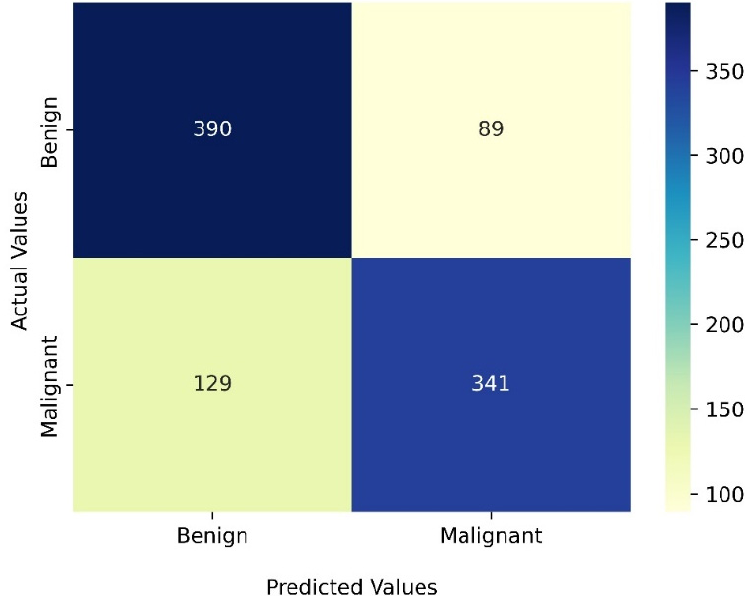
Figure 4. Confusion matrix of the two-view tiny DeiT’s classification results. Table 2. Result comparisons of the proposed model and other models. Params means the number of parameters. To compute p -values for different two-view models, the model proposed in paper [16] is used as the reference base.